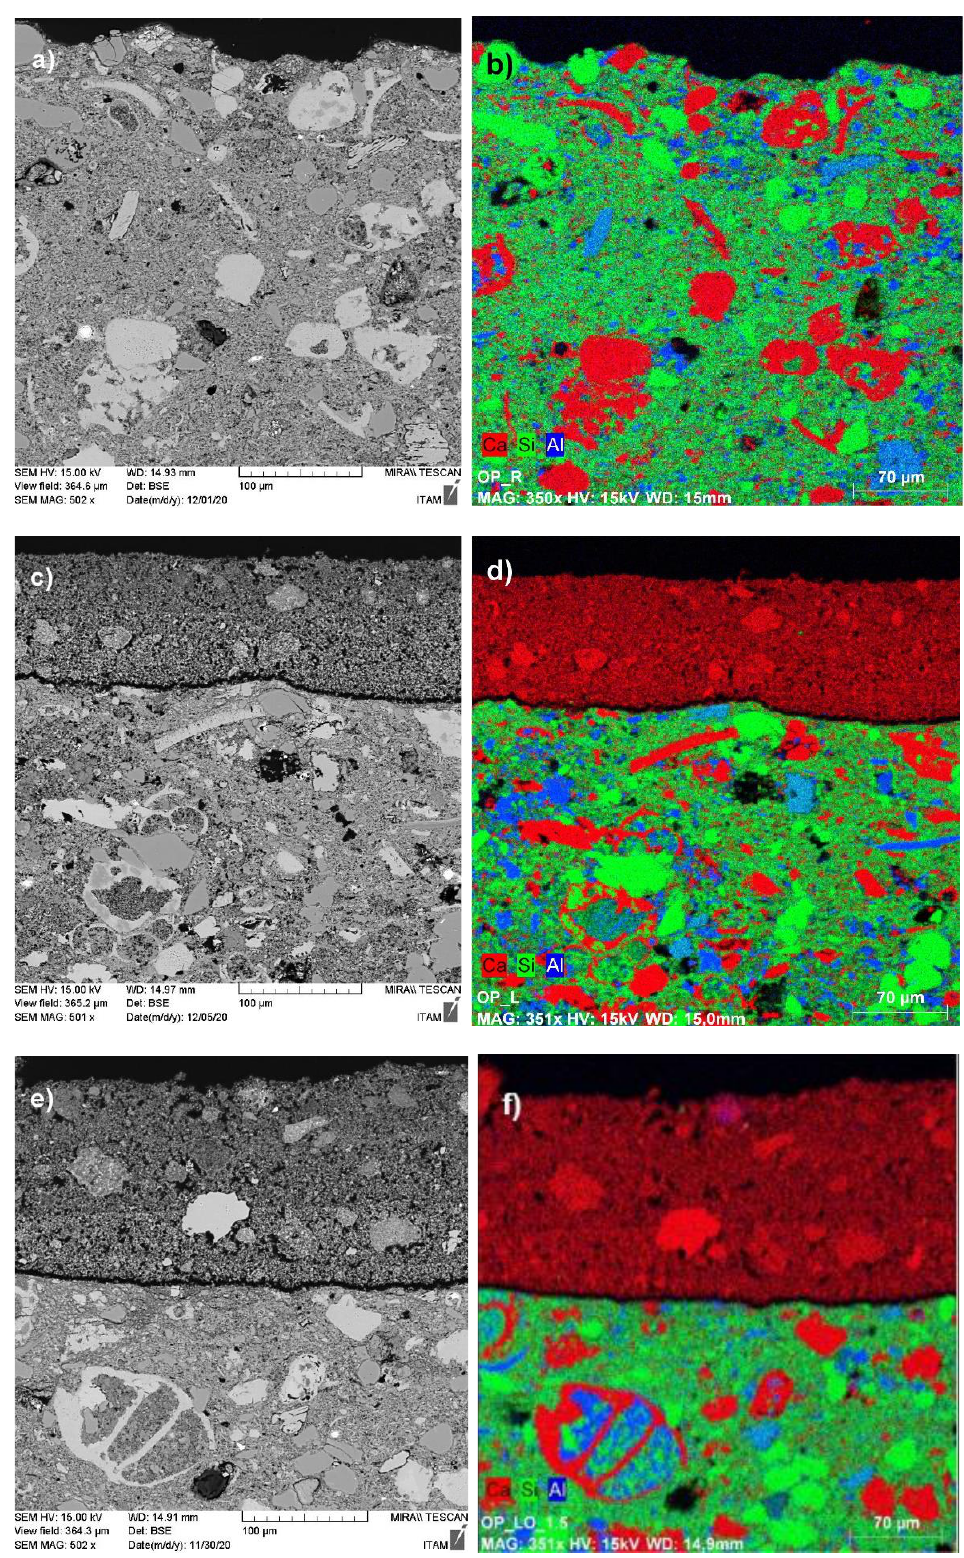
Figure 9. SEM photomicrographs of Opuka and respective EDX elemental maps: ( a ) SEM image of OP/R; ( b ) SEM-EDX map of OP/R; ( c ) SEM image of OP/L; ( d ) SEM-EDX map of OP/L; ( e ) SEM image of OP/LO/1.5; ( f ) SEM-EDX map of OP/LO/1.5.